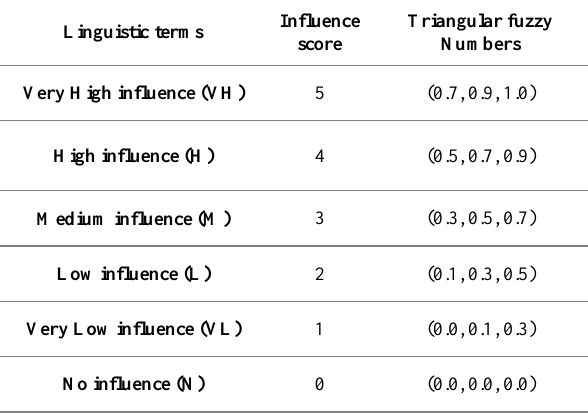
Figure 1. Triangular fuzzy numbers for linguistic